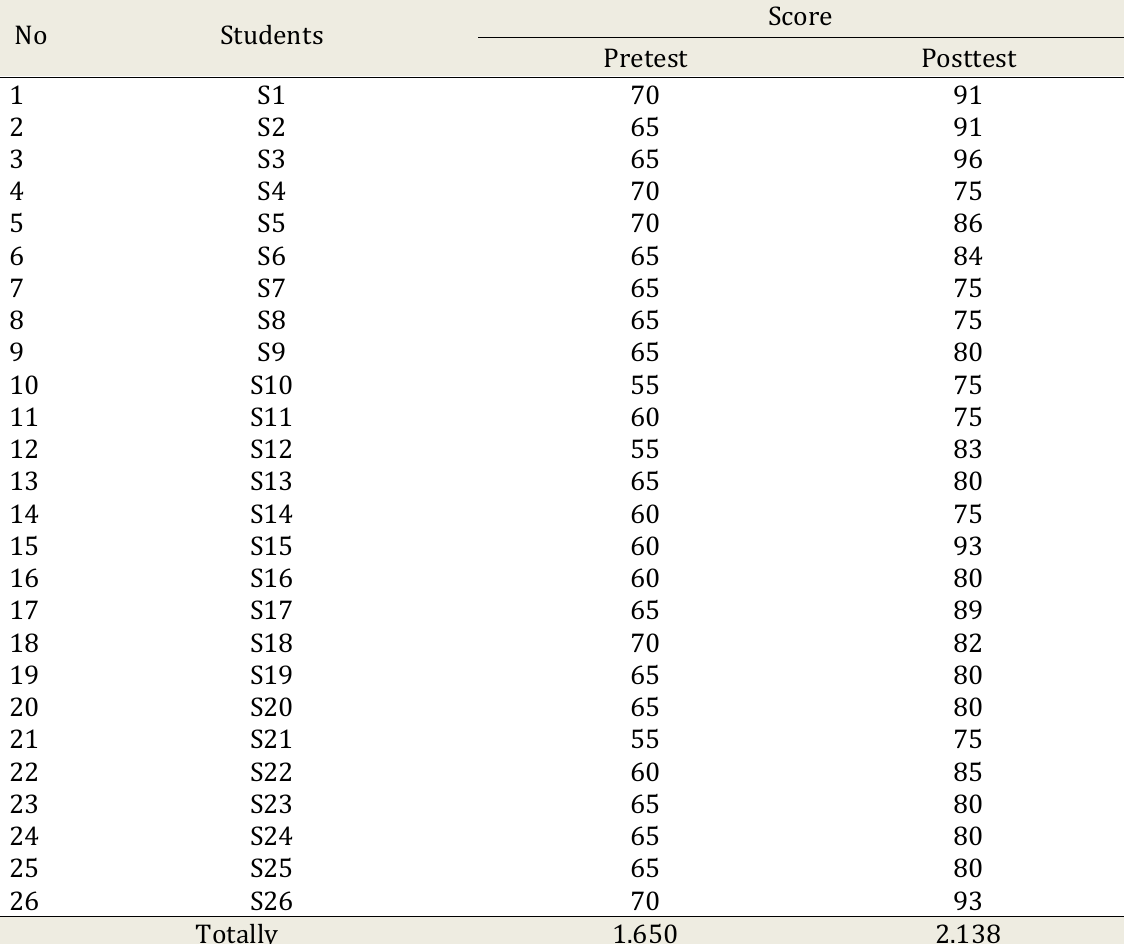
Table 4.1 The students’ in prete st and post-test result